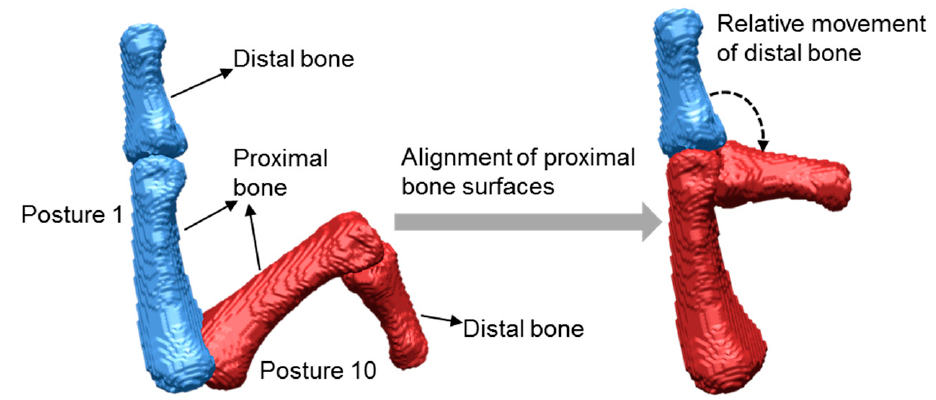
Figure 6. Alignment of the proximal bone surfaces of a joint at two postures to measure the relative motion of the distal bone of the joint between the two postures.